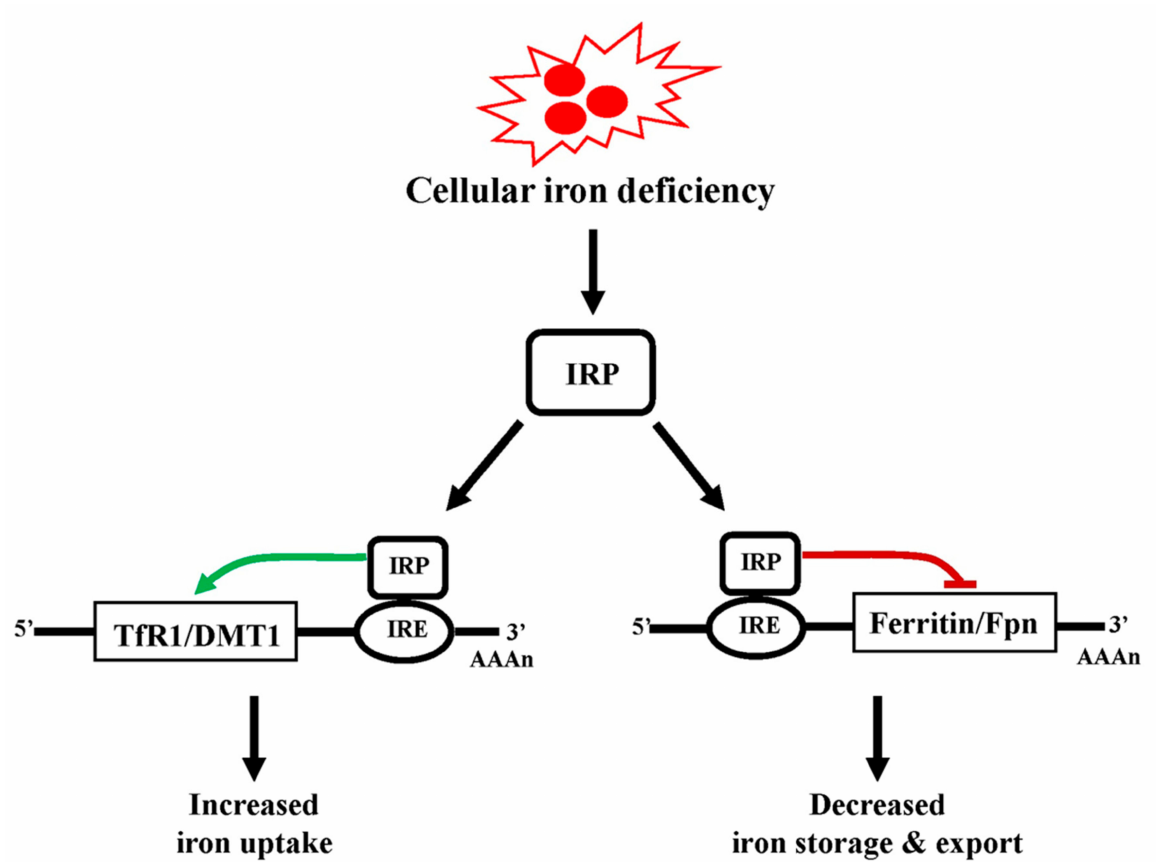
Figure 4. Cellular iron regulation. Deficiency in cellular Fe 2+ is sensed by iron regulatory proteins (IRPs). Upon sensing decreased iron, IRPs bind to an iron response element (IRE) found in the 3 (cid:48) untranslated region (UTR) of transferrin receptor 1 (TfR1) and divalent metal transporter 1 (DMT1) mRNA. This binding results in an increased in translation of TfR1/DMT1 proteins leading to increase in cellular Fe 2+ uptake. IRP also binds to an IRE in the 5 (cid:48) UTR of ferritin and ferroportin (Fpn) mRNA to block their translation, resulting in reduced iron storage and